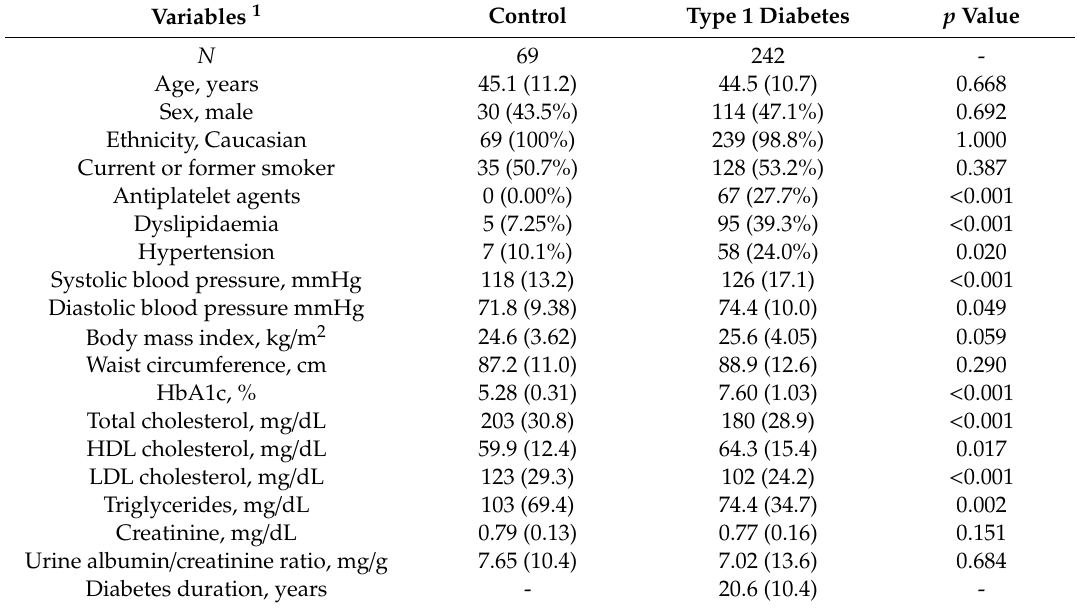
Table 1. Clinical characteristics of the study